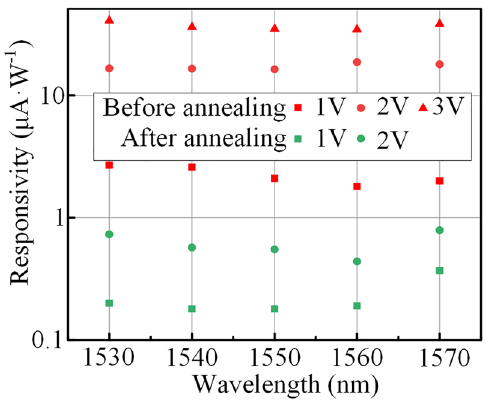
Figure 6: Comparison of responsivity before and after vacuum annealing at five operation